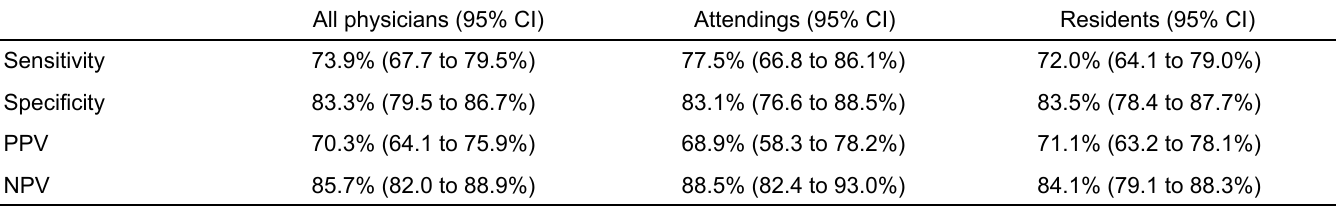
Table 1. Performance of the prediction of sick vs. not-sick patients by emergency physicians.